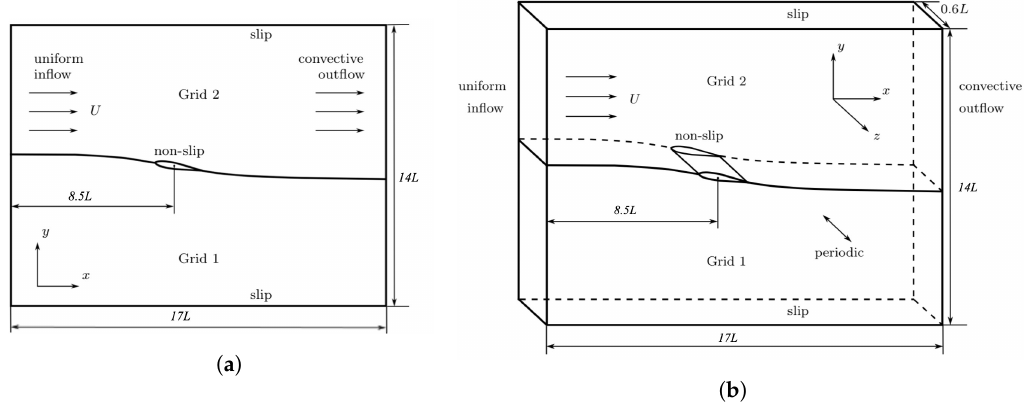
Figure 3. Computational domain and boundary conditions: ( a ) two dimensional; and ( b ) three